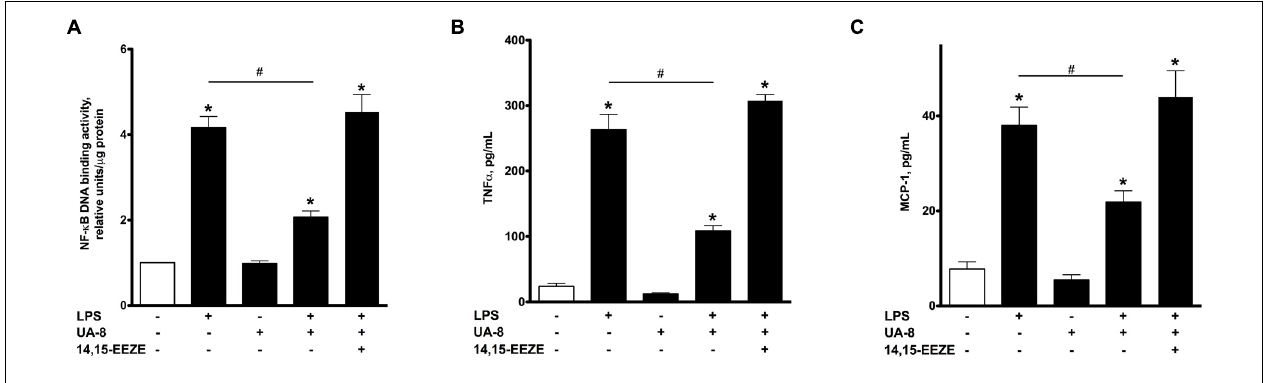
FIGURE 2 | UA-8 inhibited inflammatory response triggered by LPS in NCMs. NCMs were treated with LPS (1 μ g/ml) and/or UA-8 (1 μ m) in the presence or absence of 14,15-EEZE (10 μ m) for 24 h. (A) UA-8 suppressed LPS-triggered up-regulation of NF-kB DNA binding activity in